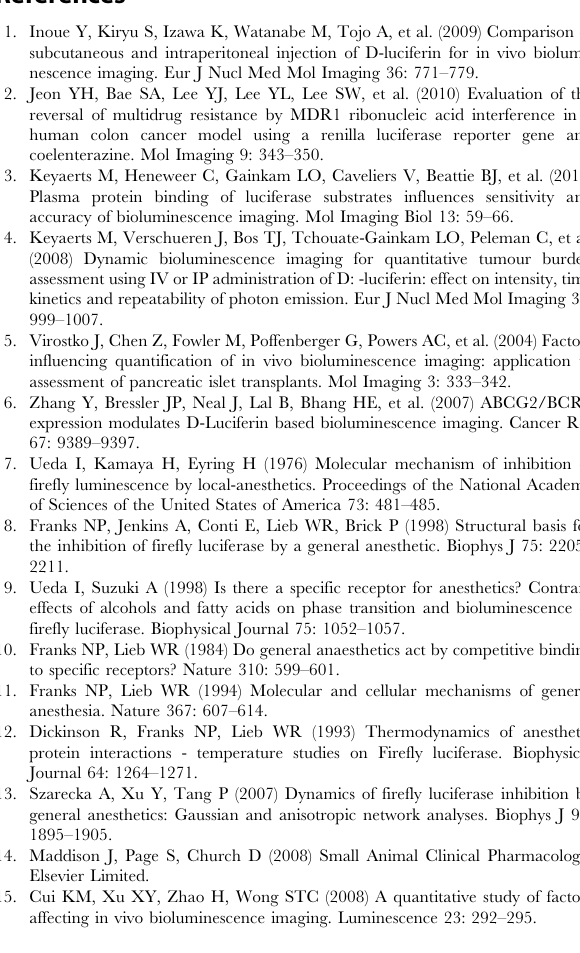
Figure S1 Comparison of BLI intensity using different fractions of oxygen. 1 6 10 6 R1M-Fluc cells were plated in small culture flasks and were allowed to adhere overnight. Starting 10 min before BLI measurements, cells were incubated with a continuous flow of either 100% O 2 or a mixture of different fractions of oxygen in N 2 above the cell media. Quantification of the BLI signal intensity showed no significant differences (n= 4). (TIF) Figure S2 Principles of unanesthetized imaging. ( A ) ‘‘ in actio ’’ module that is inserted into the camera to enable the imaging of unanesthetized mice. ( B ) Representation of the module. The registration video is done using a near-infrared (NIR) camera and a near-infrared laser for illumination. A dichroic beam splitter allows direct transmission (with 95% efficiency) of the biolumi- nescence signal while reflecting the NIR light at an angel of 90 u . ( C ) Principle of the dynamic fusion of video data and bioluminescence data. ( D ) The Laser and the intensified camera are switched on and off in opposition. When the laser is switch on, the intensifier camera is switched off and vice versa. The laser is switched on 1.5 ms every 22 ms, with a delay of 0.5 ms after the extinction of the laser. The intensified camera is then acquiring